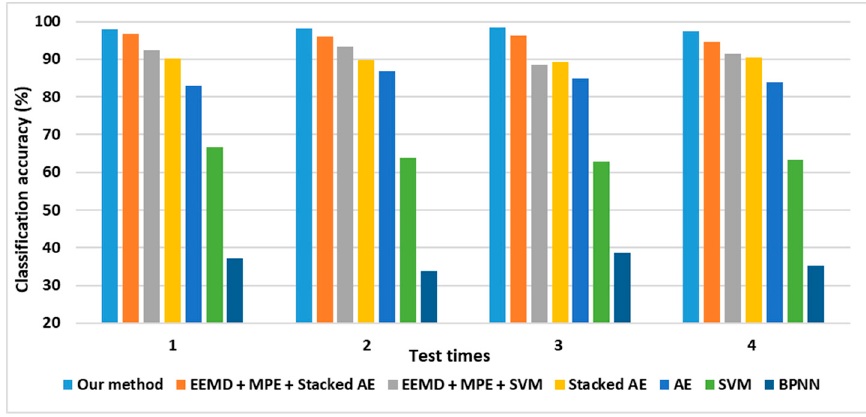
Figure 29. Diagnosis results of the four tests. Table 8. Average classification accuracy (%) of the proposed method and the comparative methods.